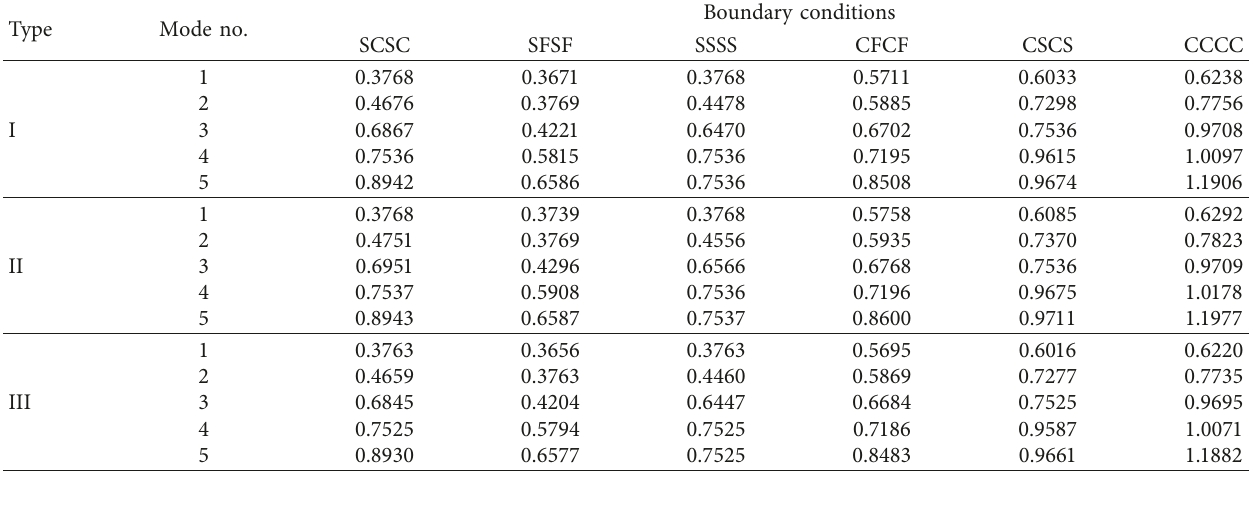
Table 5: Nondimensional frequency parameter Ω for porous rectangular plates subjected to different classical edge conditions ( e � 0.2, a / b � 0.5, and h / b � 0.2).